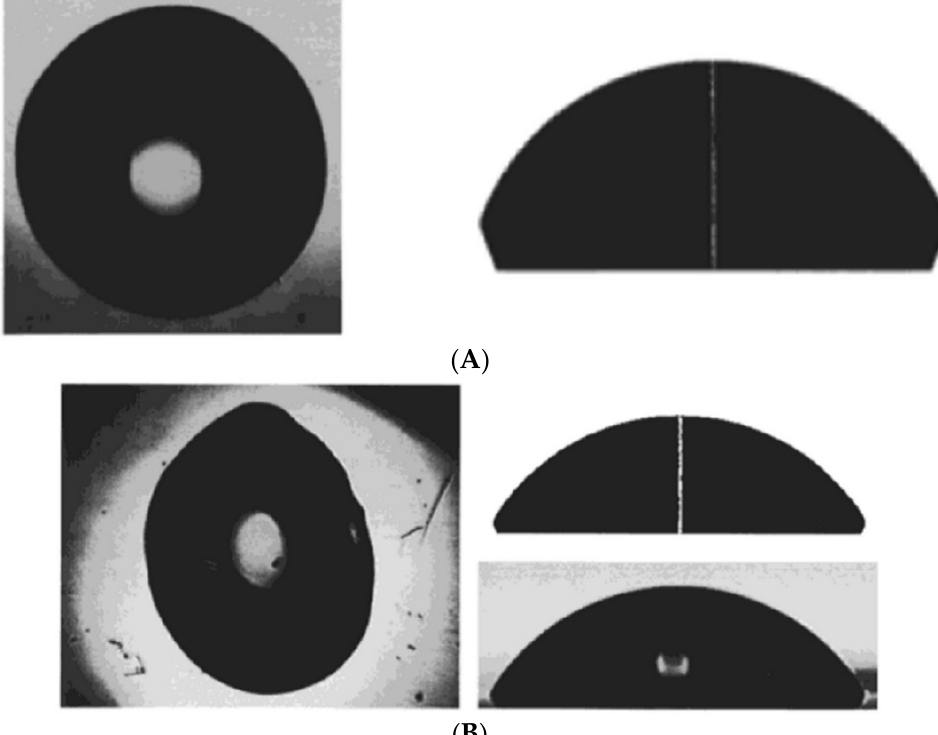
Figure 4. ( A ) Plan and side views and initial contact angle for a water drop on MYLAR (polyester) surface. ( B ) Plan and side views and contact angle for the same water drop during evaporation from the same MYLAR surface. The distortions of the drop perimeter can be clearly seen. (Repro- duced with permission from reference 4 [4], copyright 2001, American Chemical